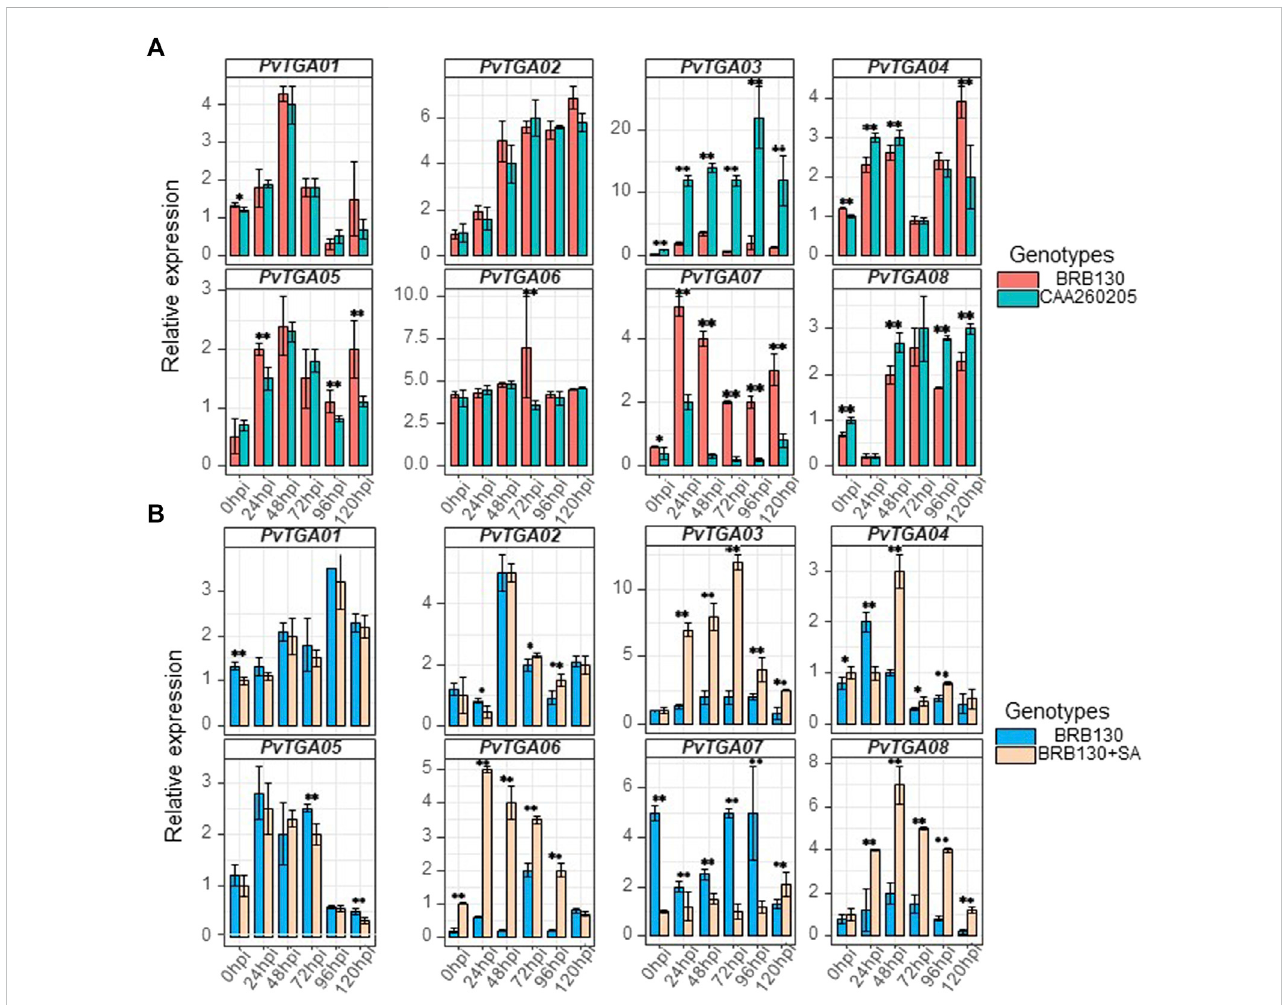
FIGURE 8 Differential expression of eight candidate genes in differernt varieties and processing. (A) relative expression of eight genes in susceptible (BRB130) and resistant (CAA260205) genotype at different time points after inoculation with Fop isolates ., (B) relative expression of eight genes in susceptible genotype (BRB130) and sprayed with SA (BRB130 + SA) at different time points after inoculation with Fop isolates . (*, p < 0.05; **, p < 0.01; Student ’ s